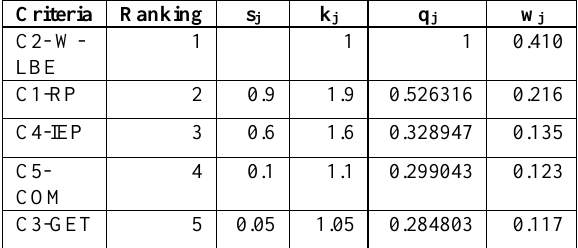
Table 6: SWARA Weighting Results for DM